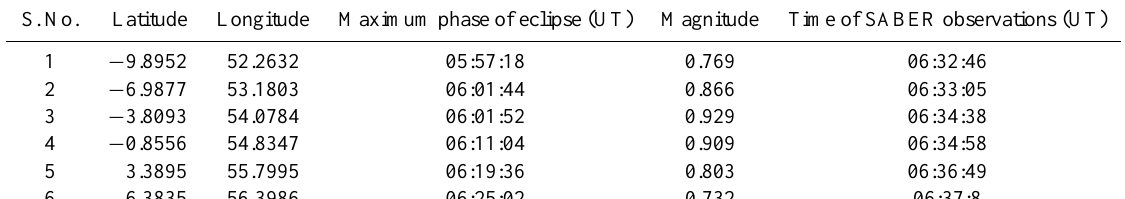
Table 1. Particulars of solar eclipse over Arabian Sea region.